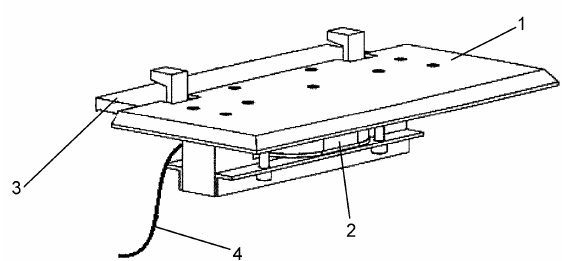
Figure 14. Induction heating system installed under the stock-rail foot; 1: heating plate, 2: inductor, 3: fastening grip, and 4: power supply wire [21,22].